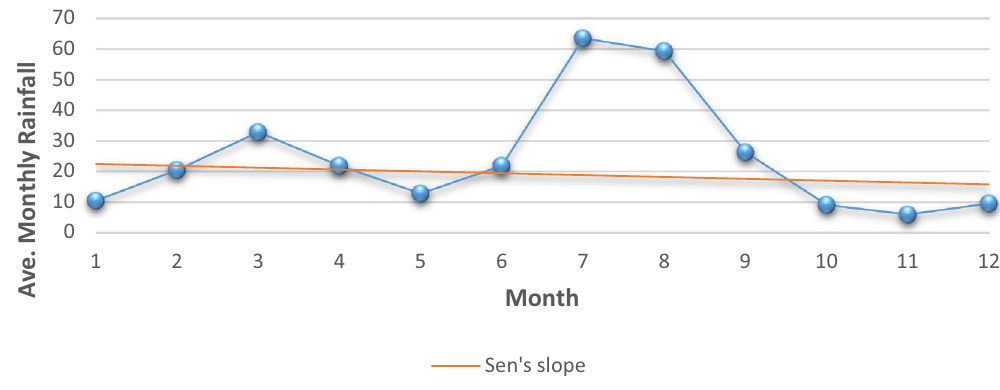
Fig. 5 A plot of average monthly rainfall for Dera Ismail Khan station. Data Source : Pakistan Meteorological Department and Regional Mete- orological Centre